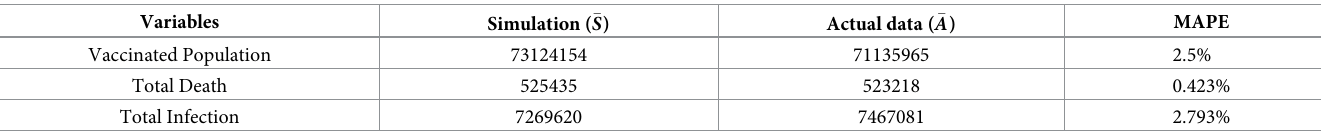
Table 2. Validation